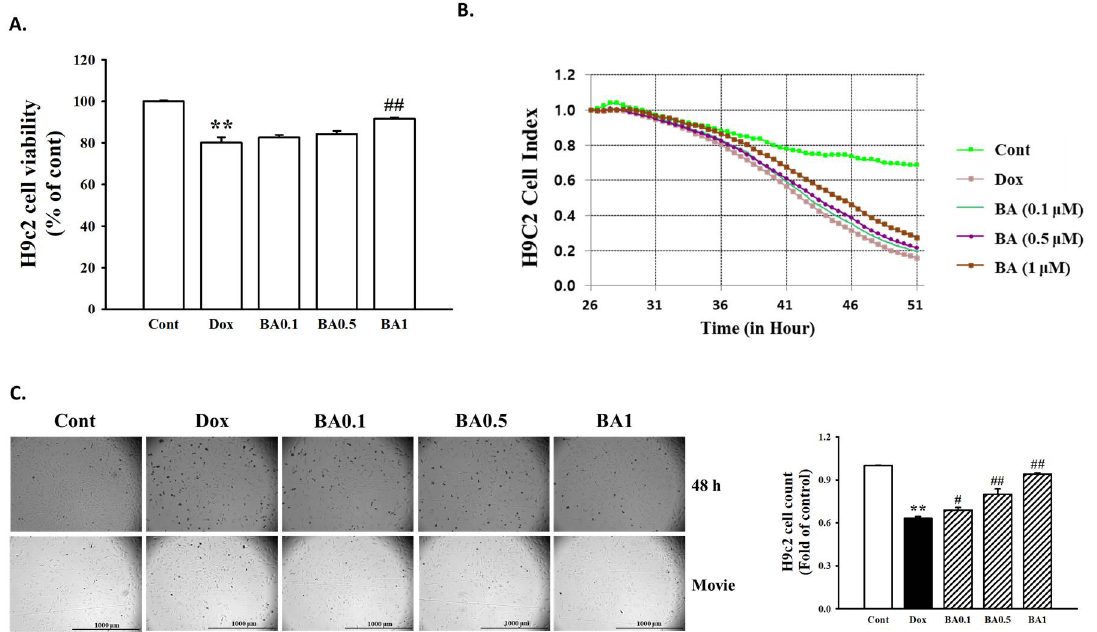
Figure 2 Figure 1. Effect of betulinic acid (BA) on doxorubicin (DOX)-induced H9c2 cell death. ( A ) Effects of BA on DOX-induced changes of cell viability. H9c2 cells were pretreatment with different concentrations of BA for 30 min prior to DOX stimulation, and the cell viability was detected by 3-(4,5-dimethylthiazol-2-yl)-2,5-diphenyl tetrazolium (MTT) assay. ( B ) The results of H9c2 cell Index using xCELLigence RTCA DP Real time cell analyzer. ( C ) Observation of H9c2 live cell imaging under the Lionheart FX Automated Microscope (Scale bar = 1000 µ m). Representative images and quantitative results demonstrating that BA (0.1–1 µ M) inhibited DOX (1 µ M; 48 h)-induced H9c2 cells. All experiments were performed at least three times. Data represent mean ± SD. ** p < 0.01, vs. control; # p < 0.05, ## p < 0.01, vs. DOX-treated